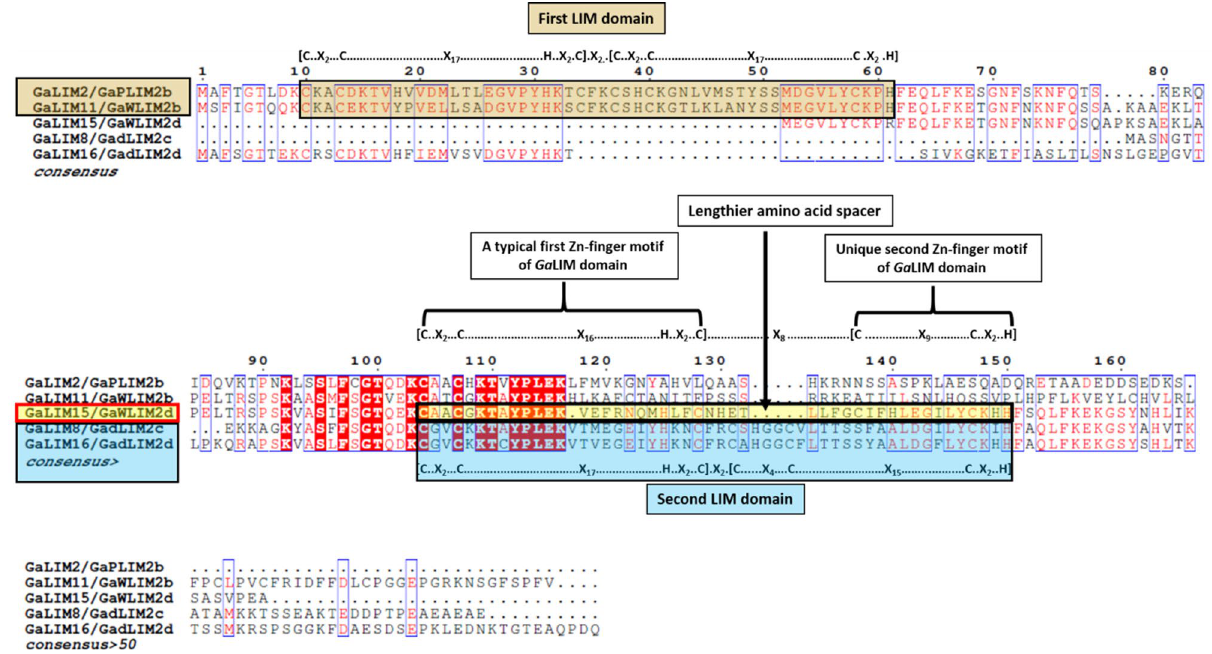
Figure 1. Multiple sequence alignment of single LIM domain GaLIM